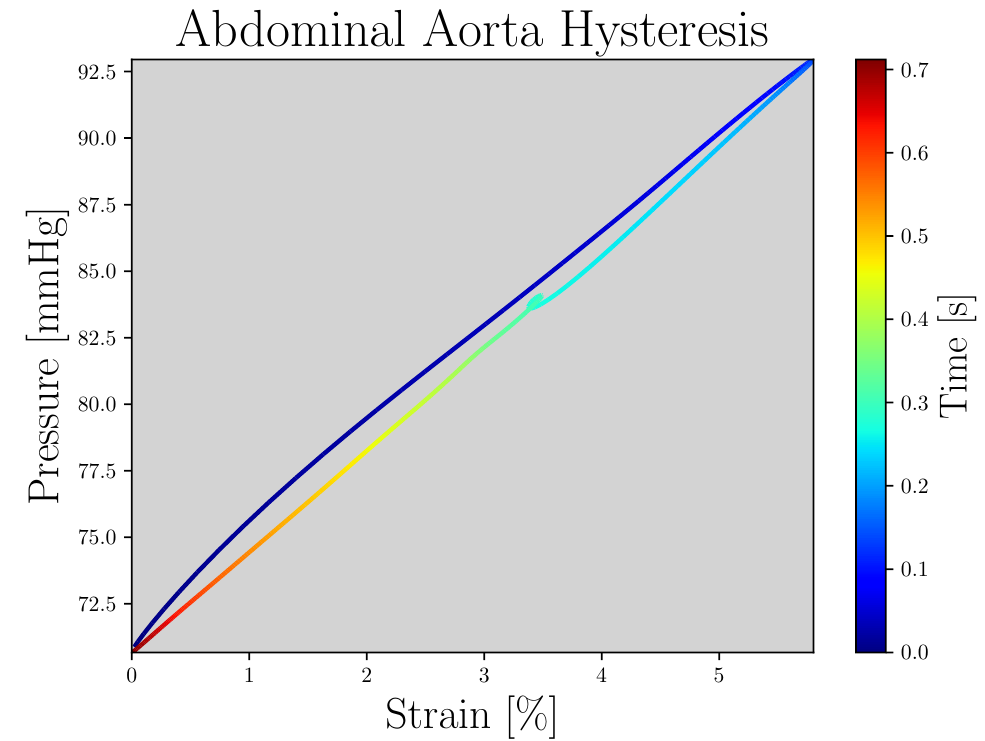
Figure 1. Abdominal aorta pressure–strain hysteresis loop; the color of the line refers to the time. For the present study, the pressure from the radial and brachial artery (P Bra-Rad ) signals correspond to the X domain (the blue and green lines in Figure 2) and the aortic abdominal pressure and area (P-A Abdo ) signals correspond to the Y domain (the red lines in Figure 2). Although PWs are noiseless, a pre-processing stage is performed to prepare the model’s input. First, the area magnitude is converted to cm 2 . Second, because PWs have different durations, the time-window is fixed to the maximum PW duration across the database; shorter pulses are repeated until time-windows are fulfilled, considering a stationary situation. Third, a MinMax [ 1, 1] normalization is performed for both pressure − and area magnitude. Finally, PWs are resampled from 500 Hz to 256 Hz, which is done for two reasons: (1) to reduce computational cost, and (2) because 256 Hz is a common sampling frequency used in commercial devices (SphygmoCor®XCEL, AtCor Medical, Sydney,